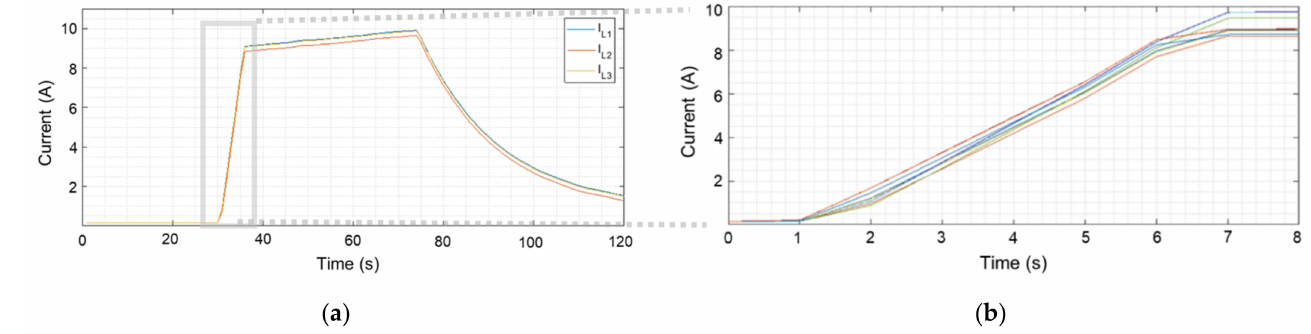
Figure 5. ( a ) Automated Guided Vehicle—Current trend of the AGV for a full charge cycle. ( b ) Rise in the RMS Value of the current during start of the charging